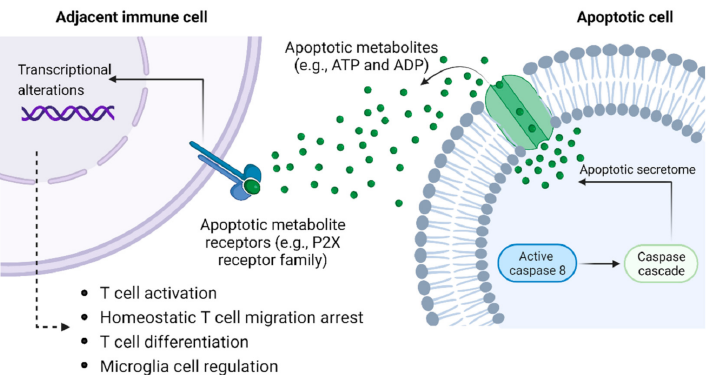
Figure 3. Apoptotic metabolites as QS-like regulators of immune cell function. Apoptotic metabo- lites released by cells undergoing apoptosis can induce transcriptional programs similar to QS to synchronize and coordinate T cell responses (and potentially those of other immune cells) in the proximity to regulate dynamic tissue responses to infection and tissue damage. Important known apoptotic metabolites include ATP and ADP, which signal through the P2X receptor family involved in inducing T cell activation, differentiation, and migratory